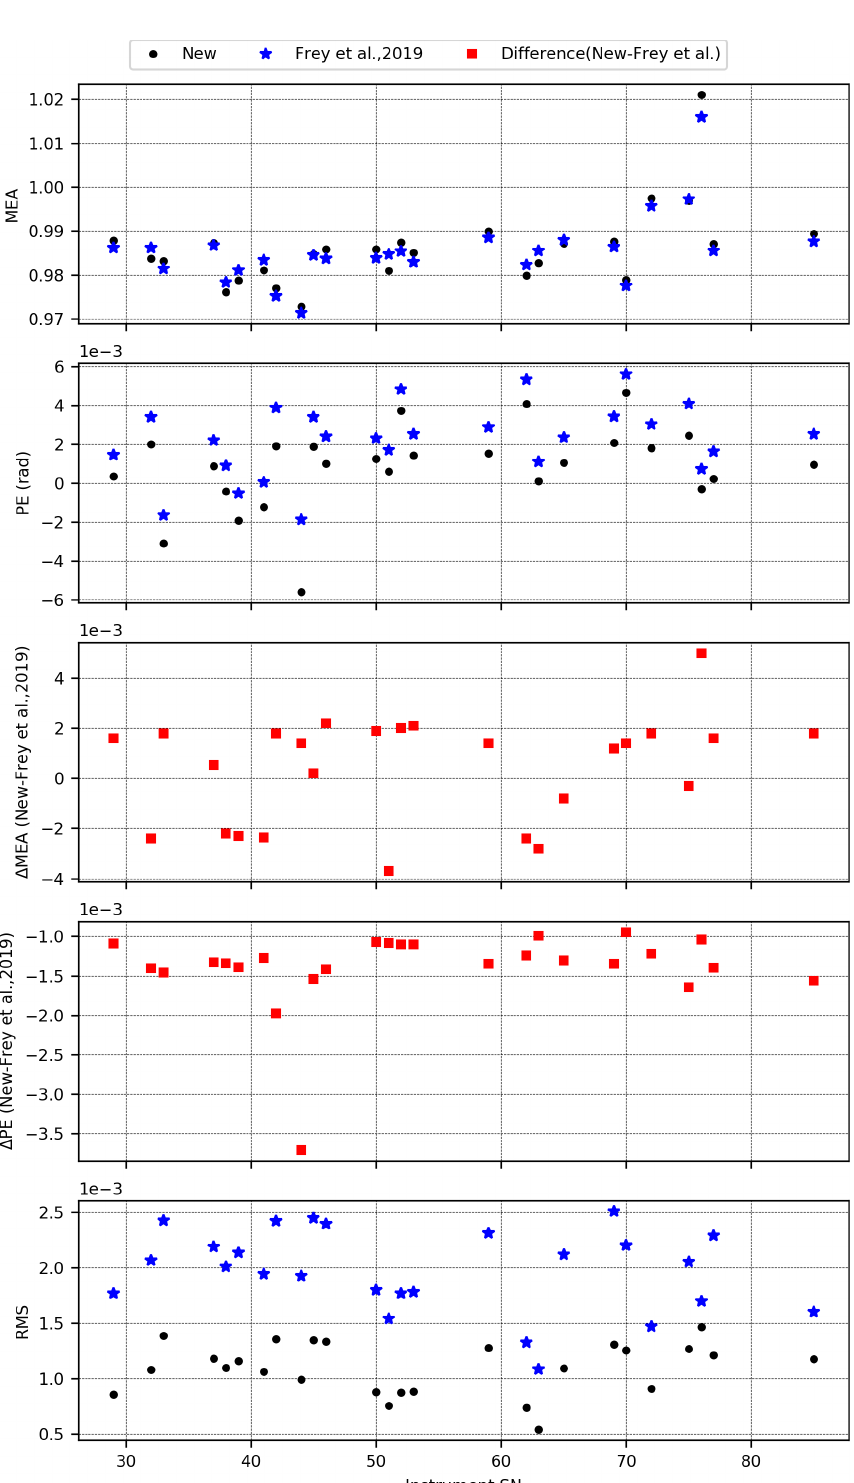
Figure 7. Comparison between the old published values (blue star) and the improved ones (black dotes). The MEA, PE and new-minus-old difference for each spectrometer. The bottom panel shows the resulting empirical standard deviation of the spectral fit for the old and the new methods,